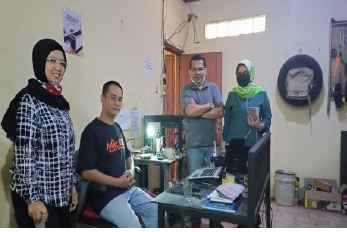
Fig. 10. The activity of monitoring IoT-based UPS's